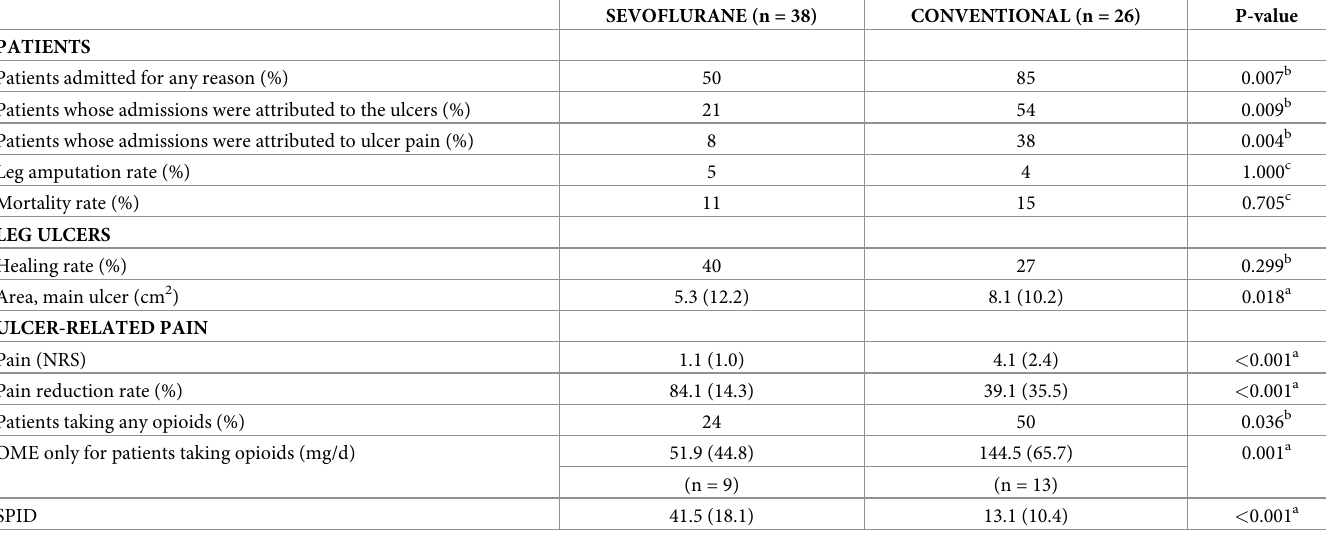
Table 2. Health outcomes for the follow-up period (12